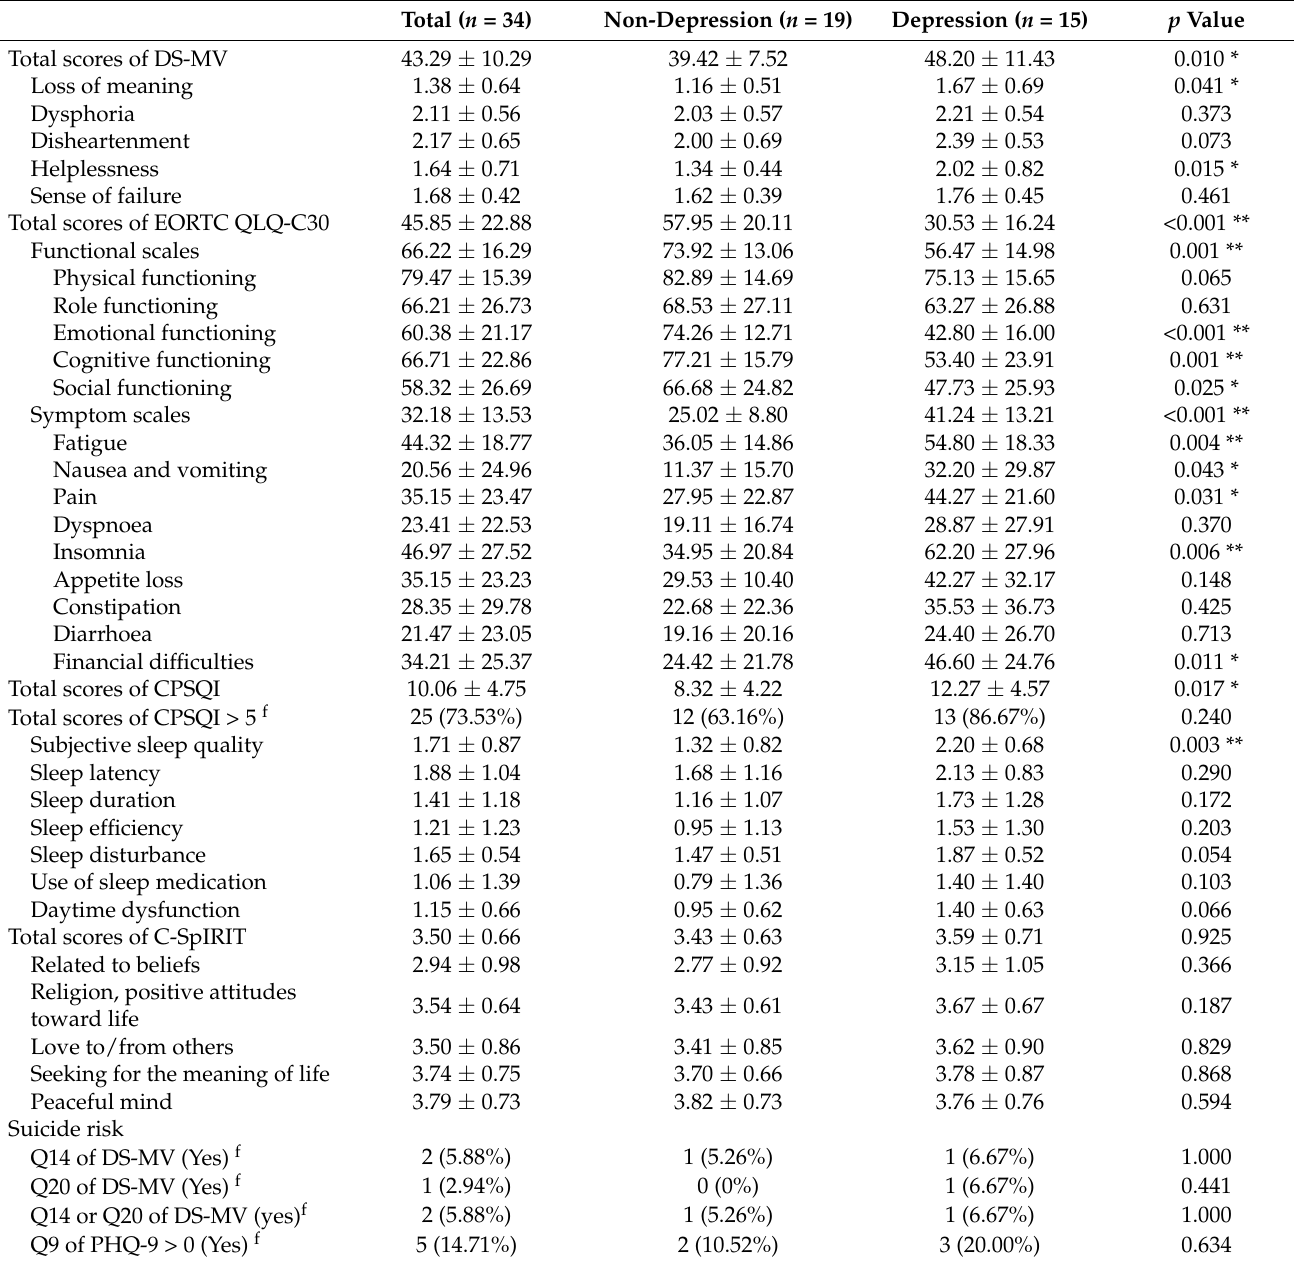
Table 5. The associations between the variables of rating scales and depression in the high- demoralization group. Total ( n = 34) Non-Depression ( n = 19) Depression ( n =